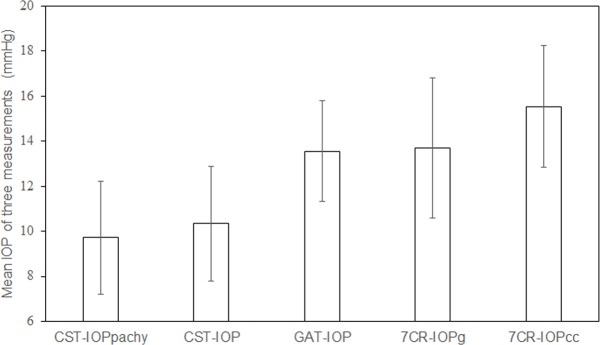
A comparison of mean IOP of three measurements using five methods.There were mean IOP of three measurements by each method on each patient (n = 90). The IOP values are plotted as the mean ± standard deviation. IOP, intraocular pressure; CST-IOP, IOP using the Corvis ST; CST-IOPpachy, corrected CST-IOP; GAT-IOP, IOP using the Goldmann applanation tonometer; 7CR-IOPg, Goldmann-correlated IOP using the 7CR tonometer; 7CR-IOPcc, corneal-compensated IOP using the 7CR tonometer.